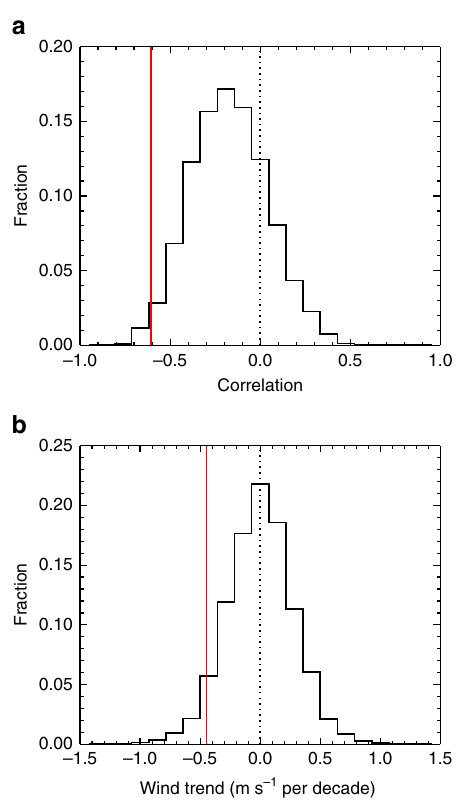
Fig. 6 Analysis of CMIP5 simulations. a Distribution of the correlation coef fi cients of averaged October zonal wind and the following western Ross Sea March ice area and b the distribution of trends in the averaged October zonal wind. The observed values are shown by the red line . Analysis is performed on all possible 37-year segments of the model simulations for a direct comparison with the 37-year (1979 – 2015) observed timeseries. For the analysis shown here, October zonal winds are averaged over the region shown by the black box on Fig.